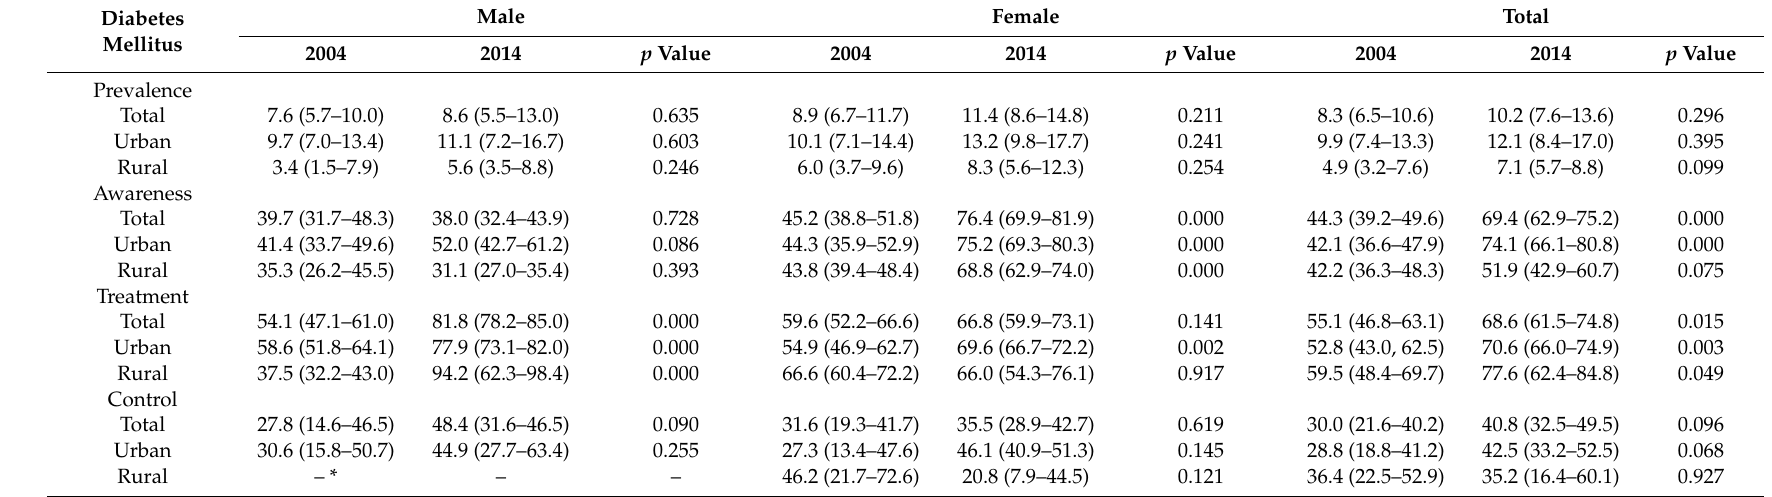
Table 2. Age standardized prevalence, awareness, treatment and control of diabetes mellitus among 25–74-year-old citizens in 2004 and 2014, Yangon Region, Myanmar.